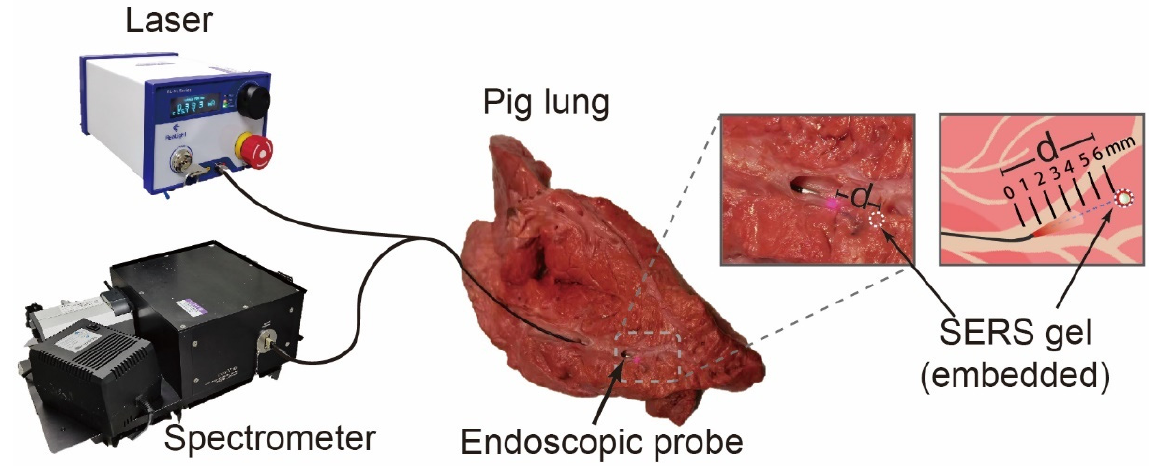
Figure 3. Raman assessments on ex vivo lung tissues using the fiber optic probe.